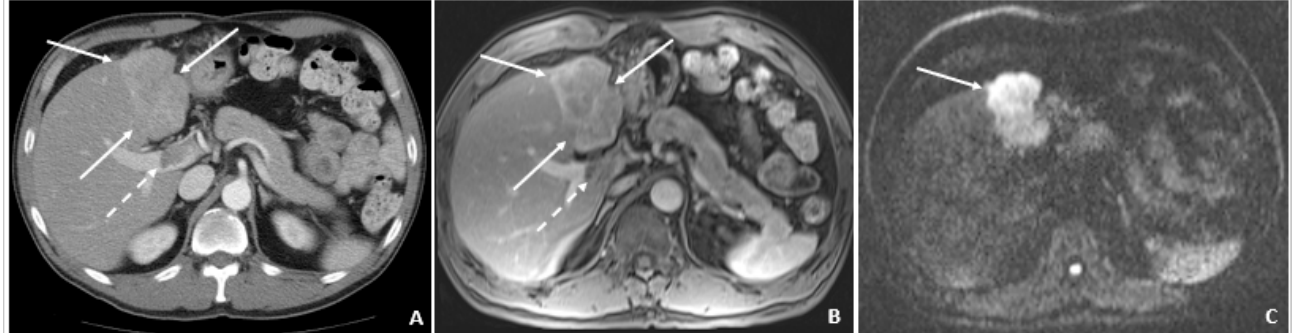
Figure 3. Recurrent HCC 2 Years Later (April 2011). ( A ) The contrast-enhanced CT image shows a hyperenhancing lesion in the left lobe (arrows) with adjacent tumor thrombus within the portal vein (dashed arrow). ( B ) The subsequent axial T1-weighted fat-suppressed postcontrast MRI image shows the lesion (arrows) to a slightly better advantage, along with the portal vein tumor thrombus (dashed arrow). ( C ) The diffusion-weighted image shows marked hyperintensity (arrow) within the left lobar mass, corresponding to diffusion restriction, typical of malignant tumors.